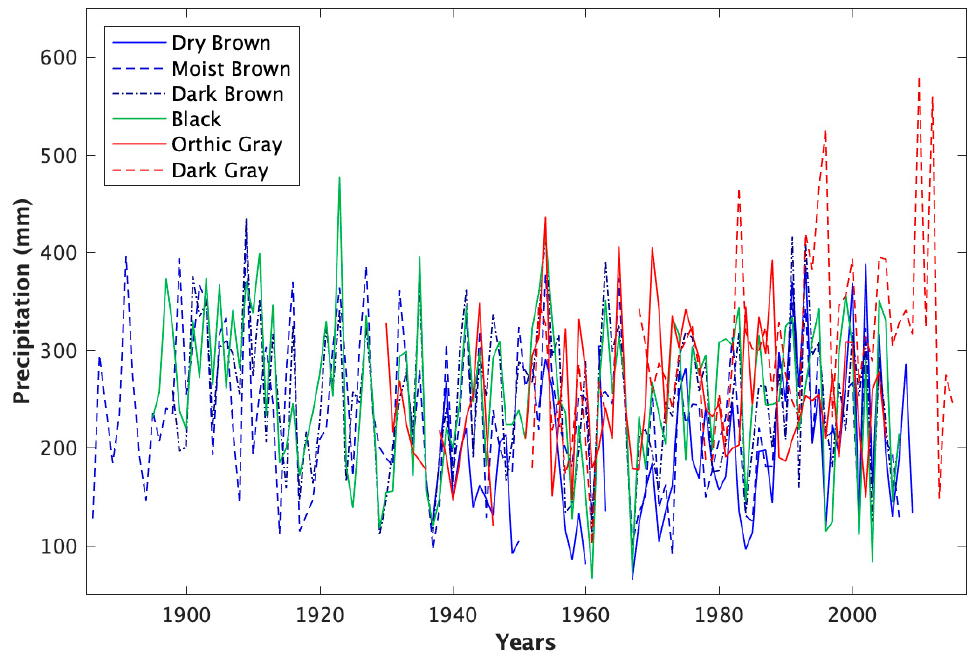
Figure 6. Growing season (May–August) maximum temperature (°C) (1885–2016) for all soil zones.